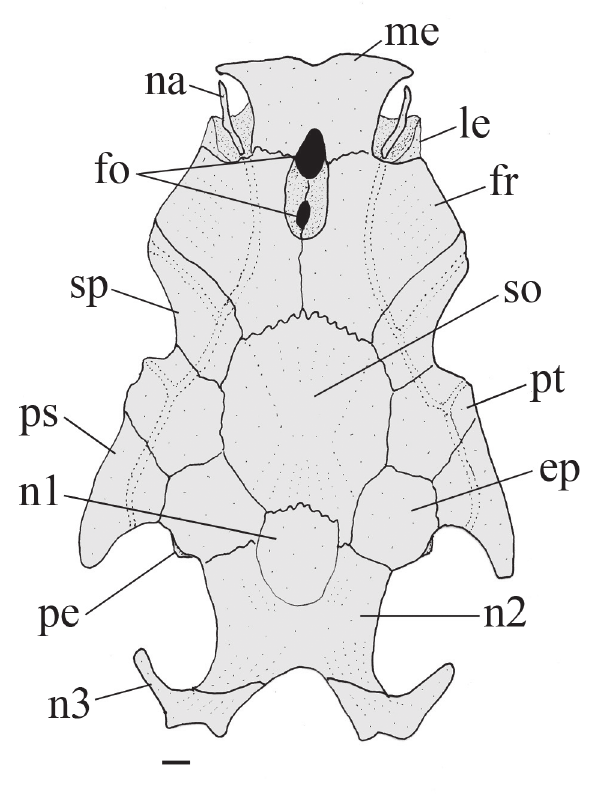
Fig. 2. Neurocranium of Glanidium botocudo , MNRJ 32539, paratype, 82.0 mm SL. Dorsal view. Abbreviations: ep, epioccipital; fo, cranial fontanel, fr, frontal; le, lateral ethmoid; me, mesethmoid; na, nasal; n1, first nuchal plate, n2; second nuchal plate; n3, third nuchal plate; pe, posterior epioccipital process; ps, posttemporal-supracleitrum; pt, pterotic; so, supraoccipital; sp, sphenotic. Scale bar = 1.0